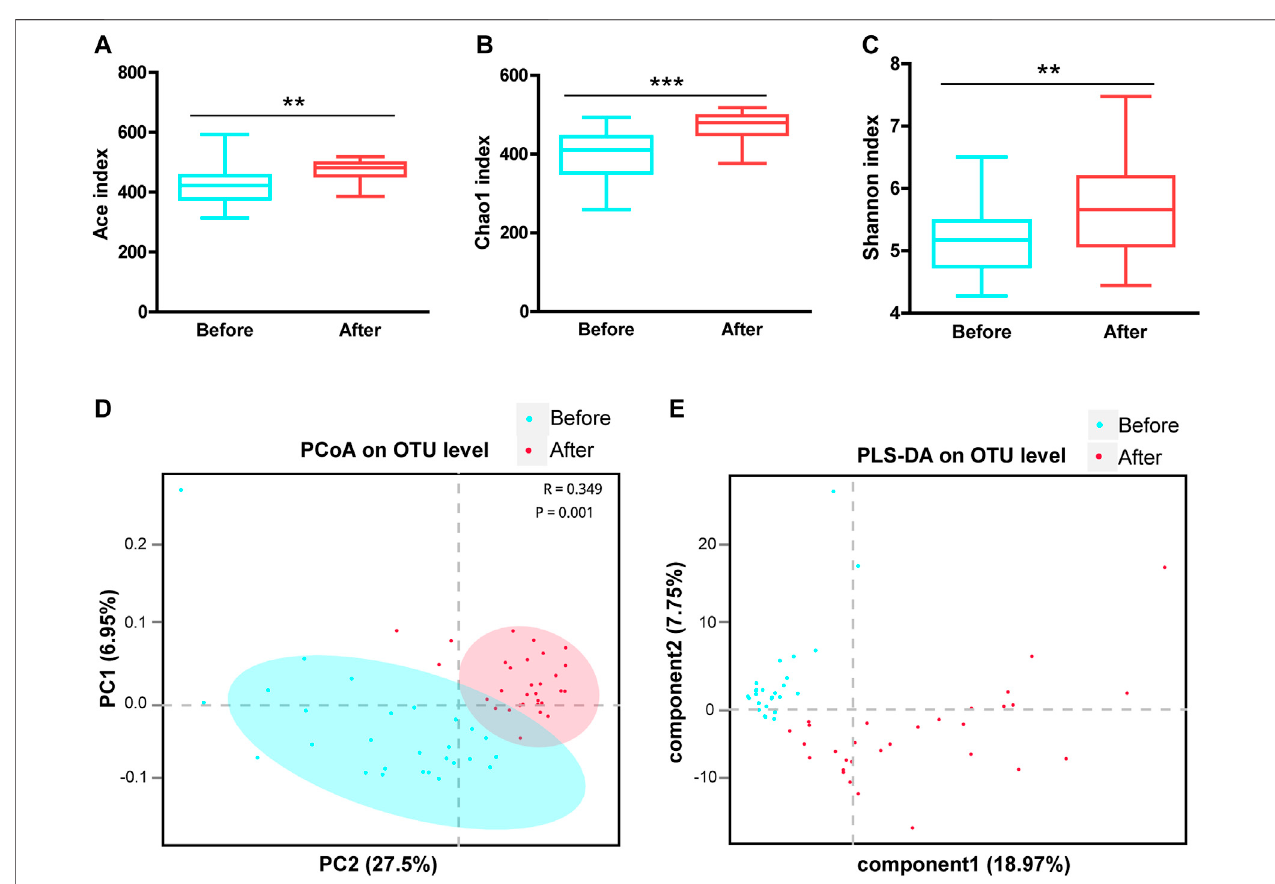
FIGURE 1 | Airway microbial diversity in the before- and after-LS capsule administration groups. a -diversity was evaluated based on the Ace (A) , Chao1 (B) , and Shannon (C) indicesoftheoperational taxonomicunit (OTU)levels. ** p < 0.01, *** p < 0.001. ß -diversity wasevaluatedbased ontheprincipalcoordinate analysis(PCoA) (D) and the partial least squares discriminant analysis (PLS-DA) (E) of the OTU levels.